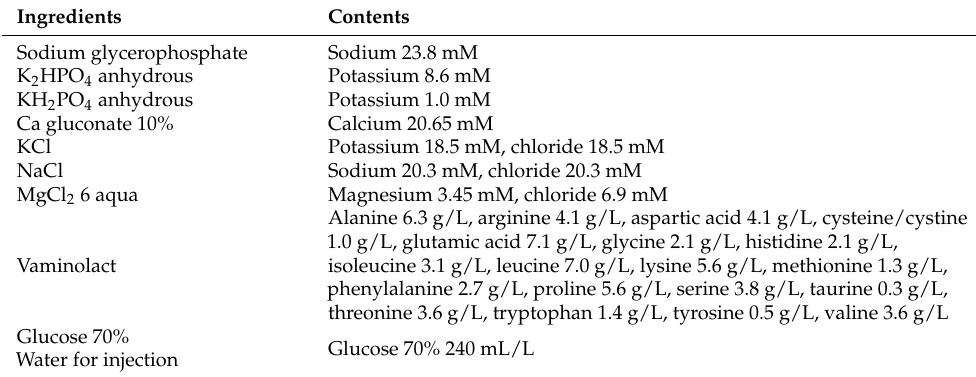
Table 9. Composition of the PN